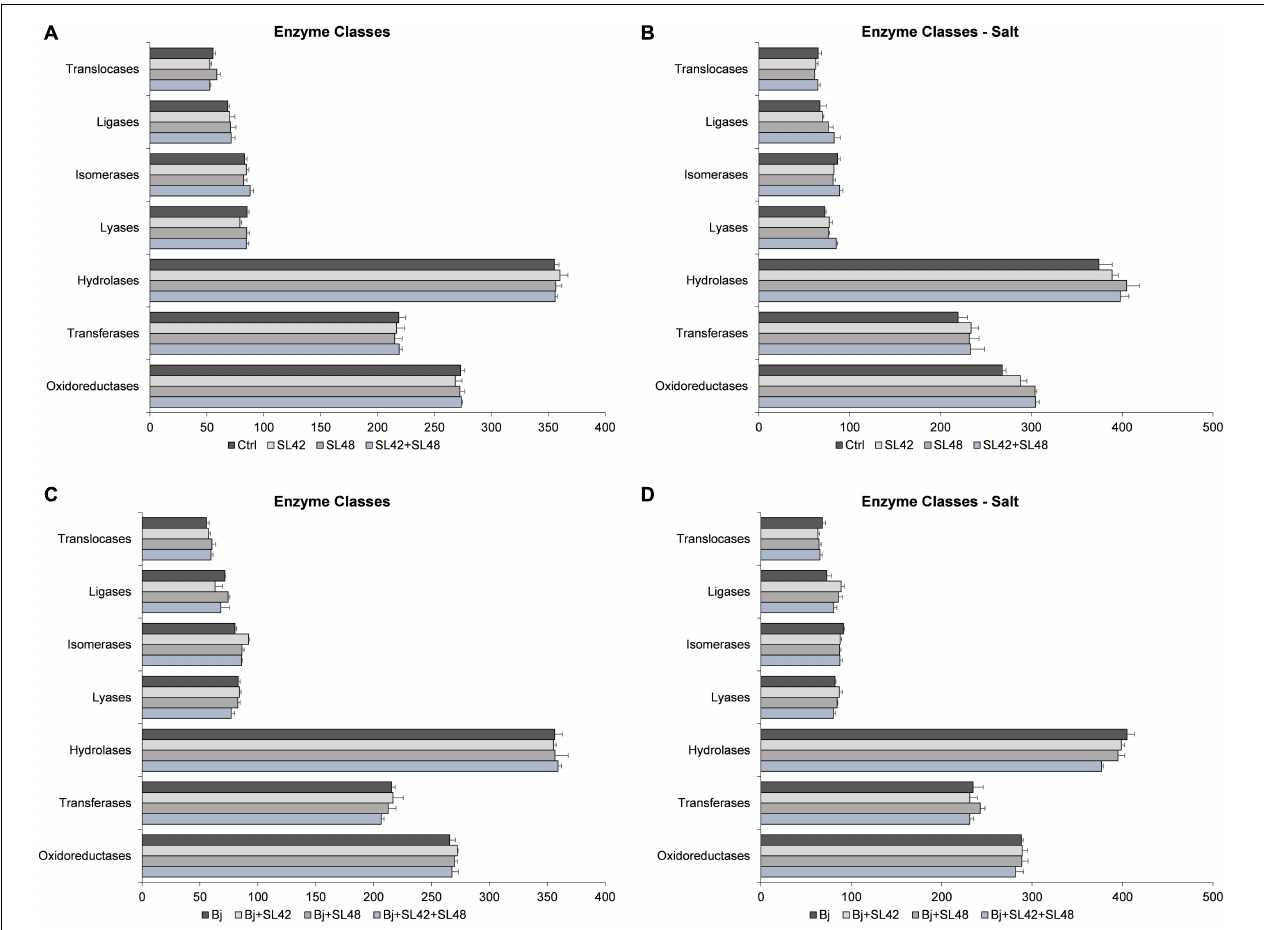
FIGURE 5 | Number of sequences involved in the enzyme classes of the soybean leaf proteome. (A) The seeds were treated with 10 mM MgSO 4 or bacterized with the strains Rhizobium sp. SL42, Hydrogenophaga sp. SL48 or co-inoculated under optimal (B) under salt stress (C) seeds were bacterized with Bradyrhizobium japonicum (Bj) as control or the strains were co-inoculated with Bj under optimal and (D) under salt stress conditions. Values represent mean ± SE ( n =